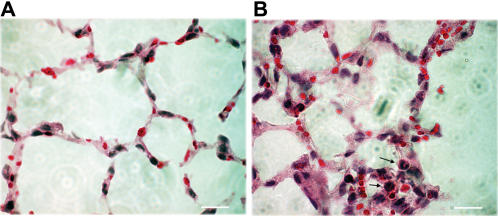
Mechanical ventilation-induced neutrophil leukocyte infiltration in lung tissue.(A) Control (non-ventilated) lung tissue. (B) Mechanical ventilation-induced lung injury following mechanical ventilation (10 ml/kg, 8 hours). Arrows point at mononuclear leukocytes in the alveoli. Hematoxylin-eosin staining, 40-fold magnification, scalebar = 50 micrometer. A representative picture is shown.